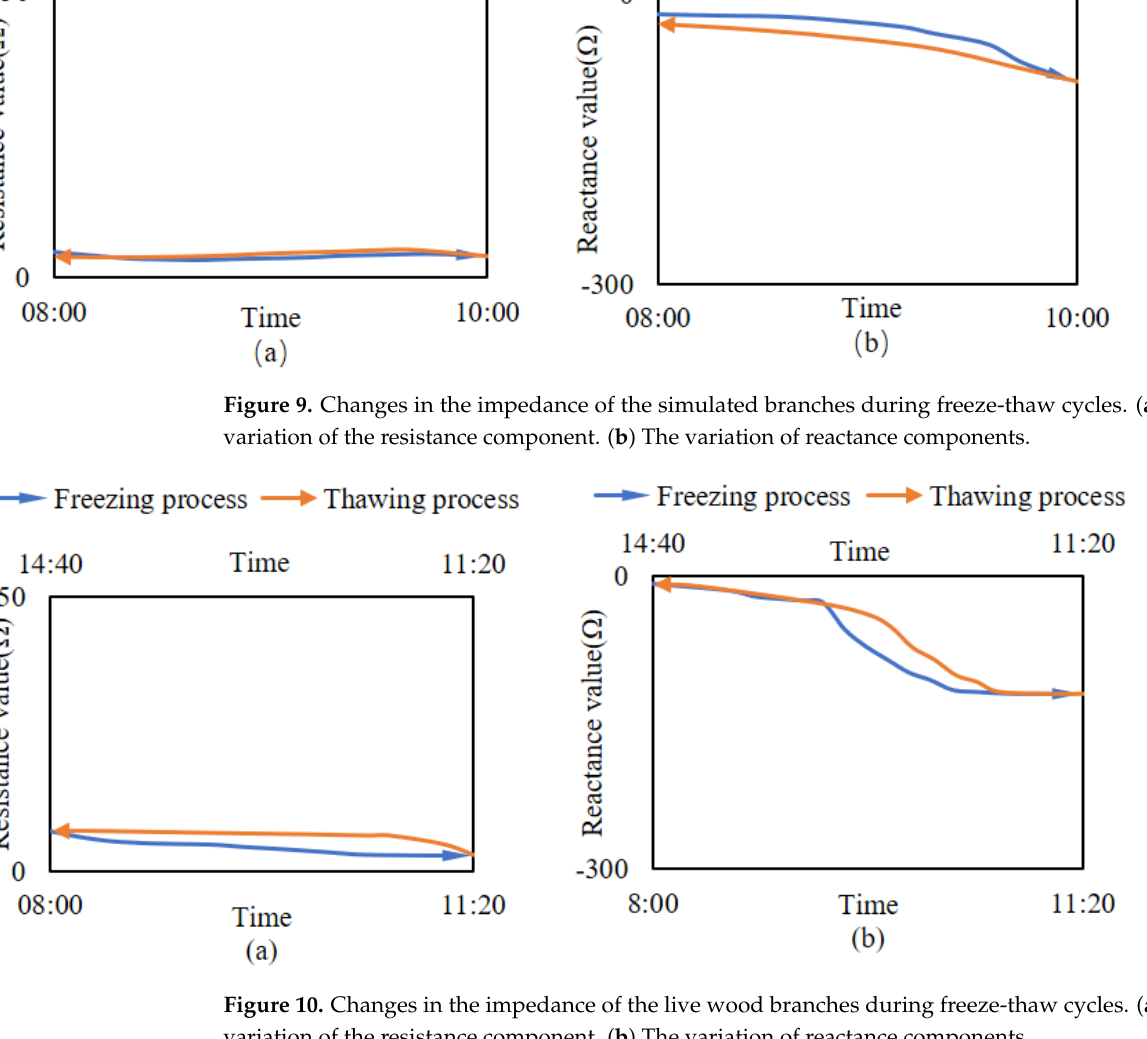
Figure 10. Changes in the impedance of the live wood branches during freeze-thaw cycles. ( a ) The variation of the resistance component. ( b ) The variation of reactance components.